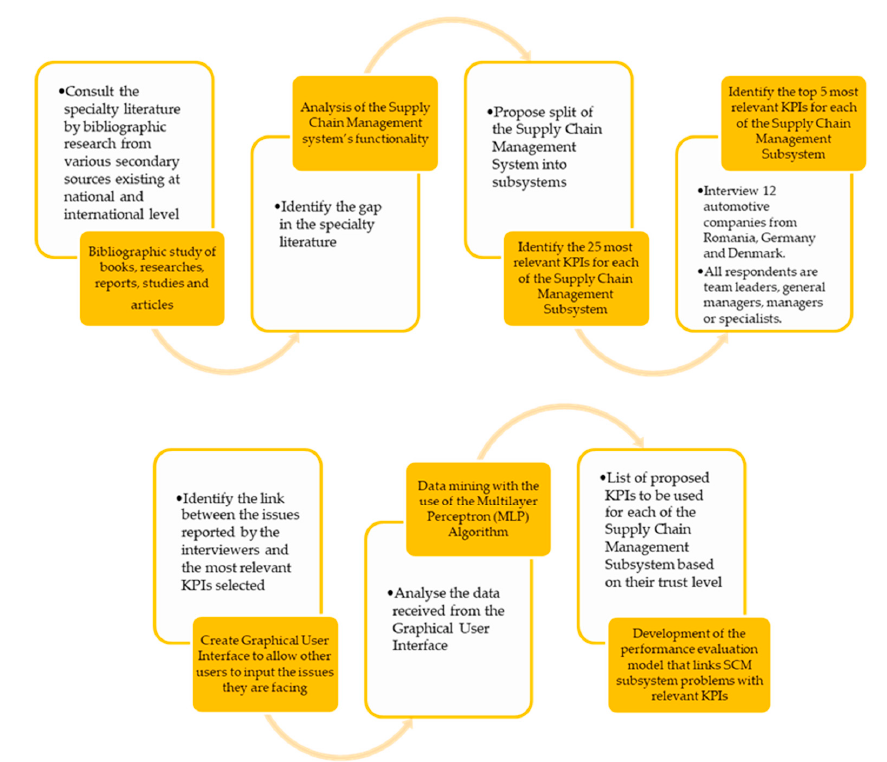
Figure 1. Logical scheme of the research methodology.